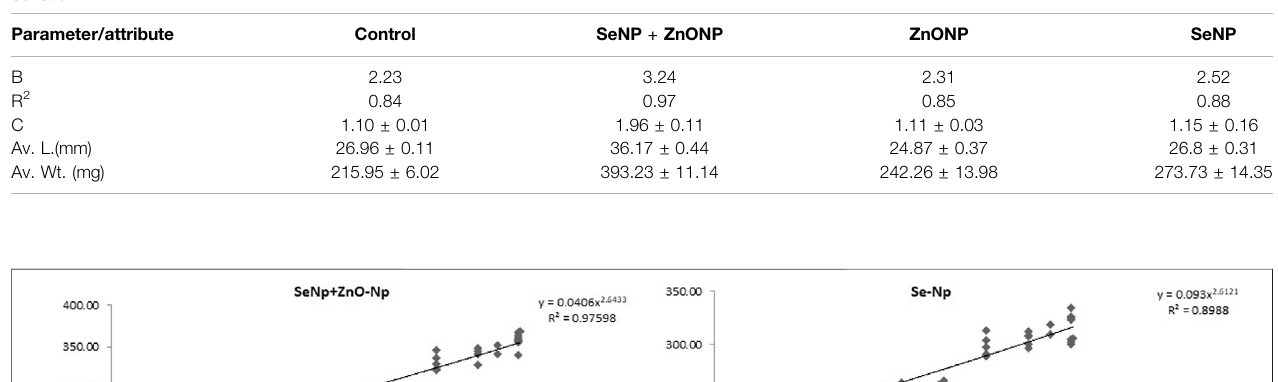
( Figure 4 ). Such fi ndings indicated that combined administration of both SeNPs and ZnONPs in fi sh feed enhances the growth of the zebra fi sh through enhancing the expression of the growth- promoting genes, which are essential for the proper growth and development of zebra fi sh.